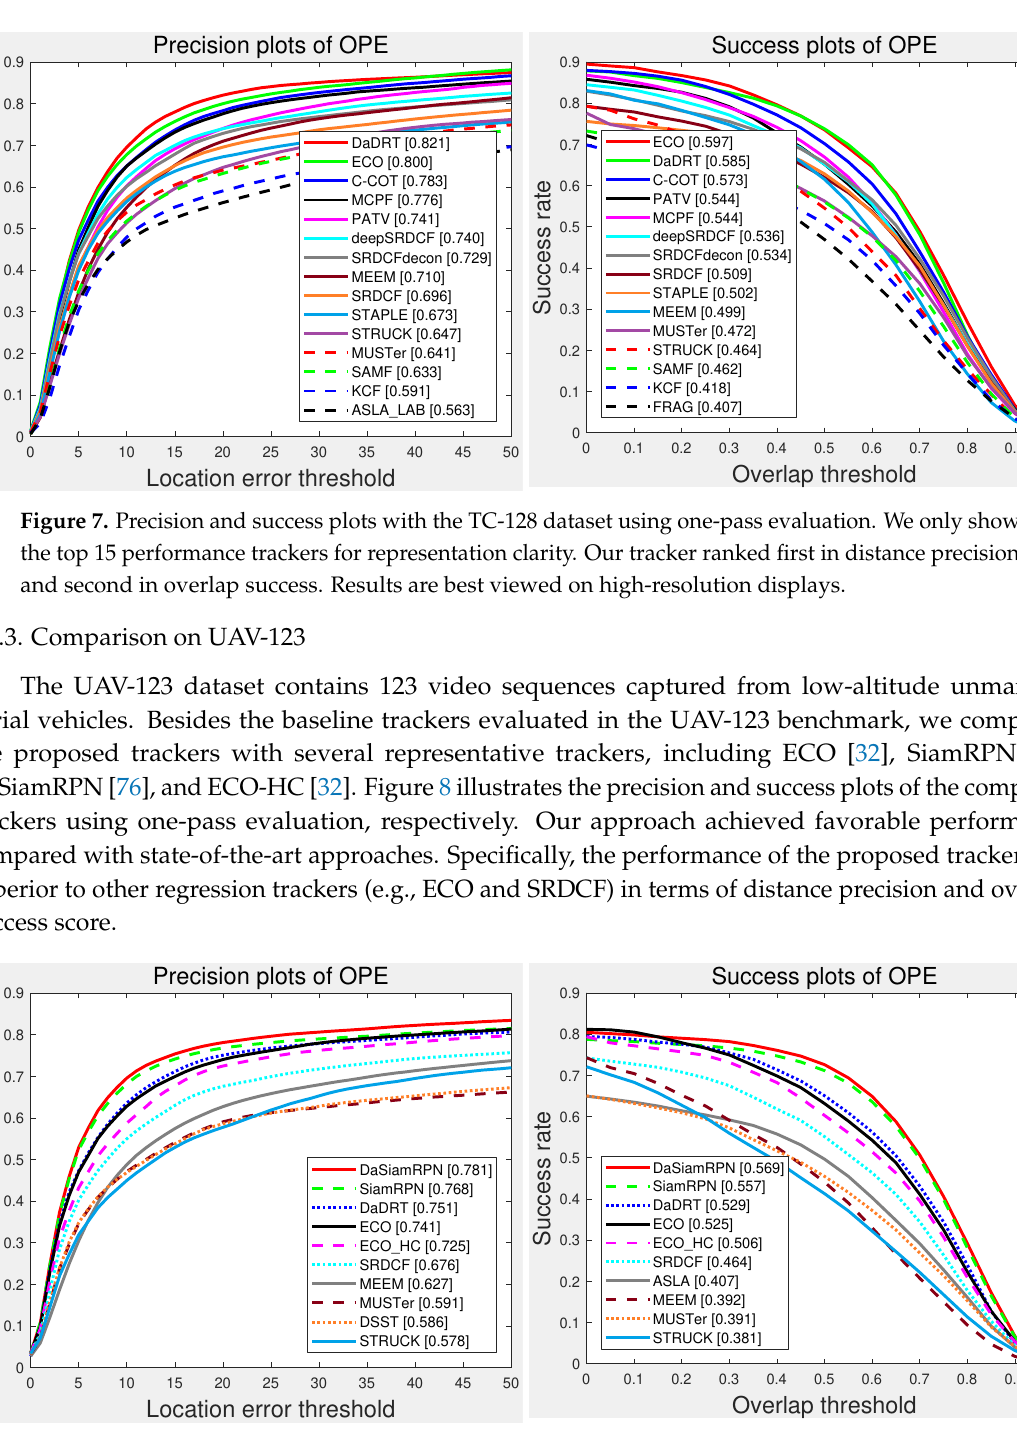
Figure 8. Precision and success plots with the UAV-123 dataset using one-pass evaluation. We only show the top 10 trackers for representation clarity. Our tracker achieved favorable performance (ranking third both in the distance-precision (DP) and area-under-curve (AUC) scores) against state-of-the-art methods. Results are best viewed on high-resolution